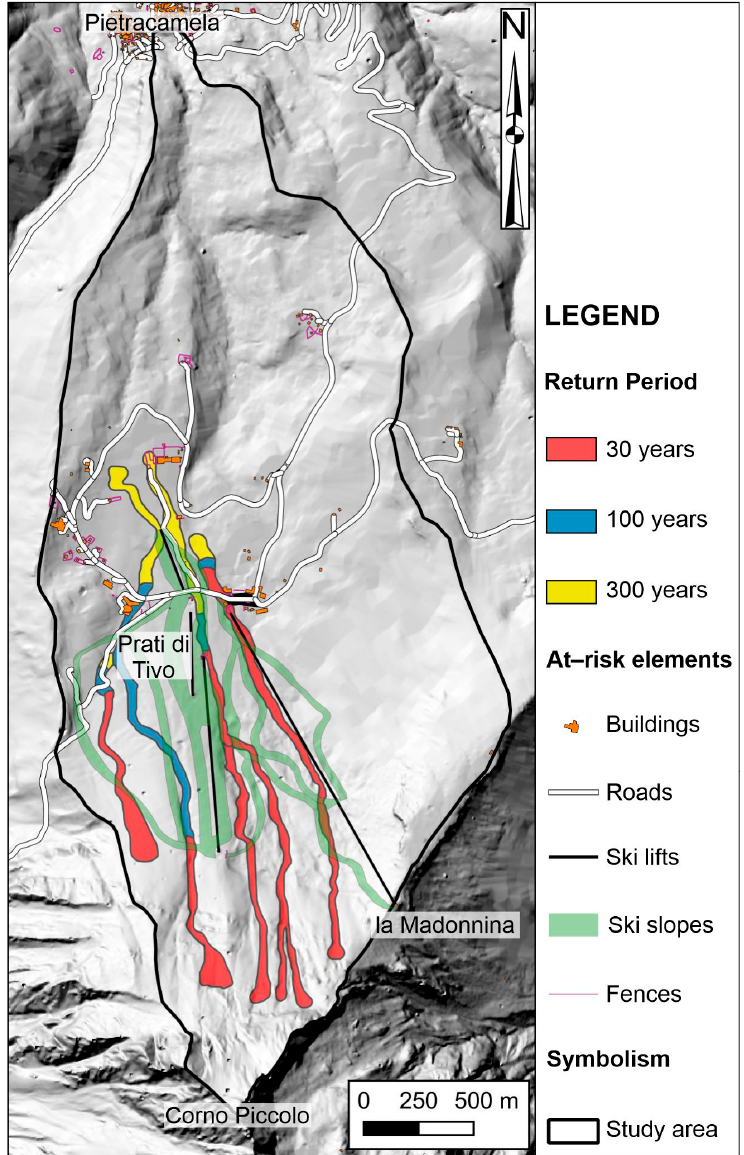
Figure 15. Avalanche hazard map of the Prati di Tivo area. Areas affected by snow avalanches with a return time equal to 30, 100, and 300 years are shown, respectively, in red, blue, and yellow.